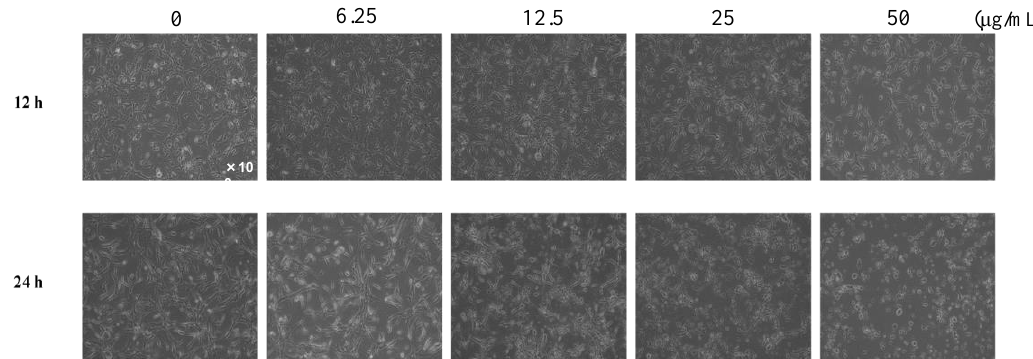
Figure 2. Inhibitory effects of ethanol extracts of EEAP1 on the tube formation of HUVECs. EEAP1 at 50 μg/mL inhibited the elongation of HUVECs and the formation of capillary networks after 12 h. After 24 h treatment, EEAP1 dose-dependently inhibited the formation of capillary networks.